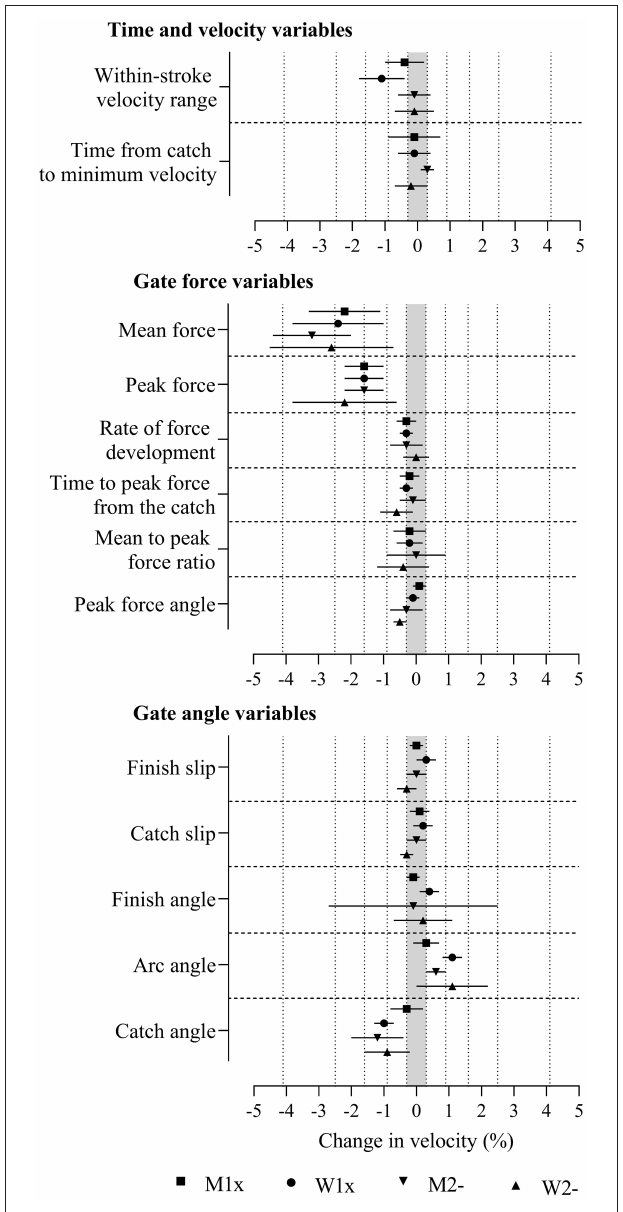
FIGURE 3 | Change in boat velocity for a change in predictor variables of two within-crew standard deviations with adjustment for power output and stroke rate in the four boat classes. Data are mean (%) and 90% compatibility limits. The shaded grey area covers values within the smallest important change thresholds (-0.3% to 0.3%). Vertical dotted lines delineate threshold magnitudes of small ( ± 0.3), moderate ( ± 0.9), large ( ± 1.6), very large ( ± 2.5), and extremely large ( ± 4.1). Rejection of the non-inferiority or non-superiority hypothesis occurs when compatibility limits do not enter the grey area. Effects with compatibility limits that end within the grey area have adequate precision but are only possibly or likely substantial. M1x, men’s single sculls; W1x, women’s singles sculls; M2-, men’s coxless pairs; W2-, women’s coxless pairs. some predictors in women’s pairs and for most predictors in men’s pairs (owing to an insufficient number of crews and